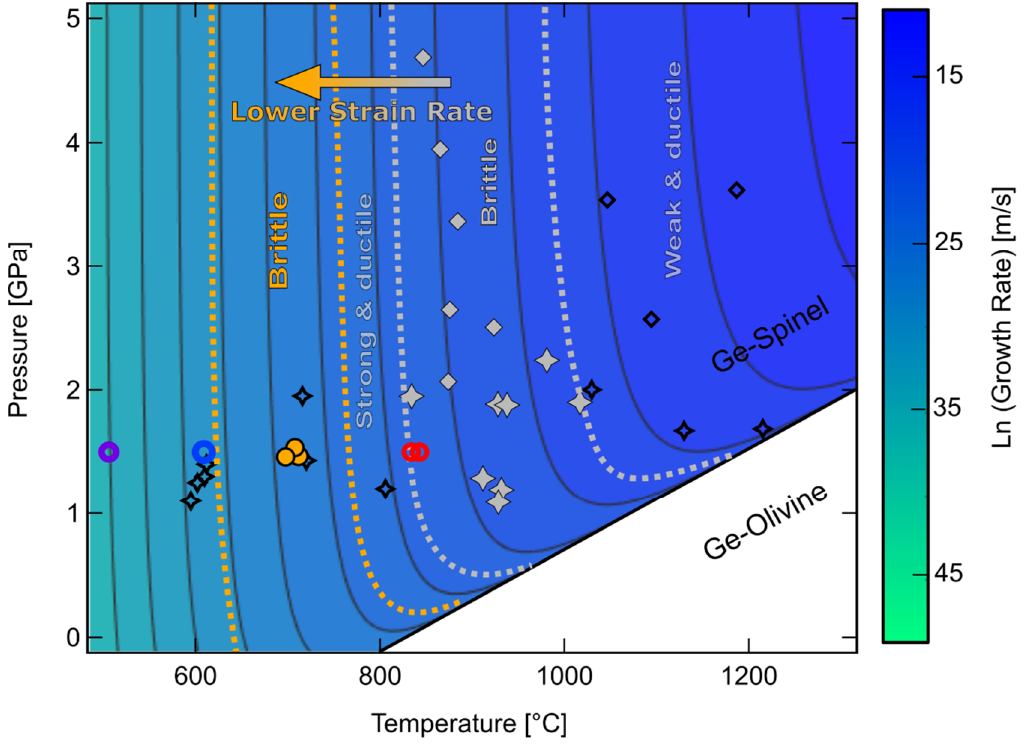
Figure 17. PT conditions of the present study (circles) and those of [15,22] (stars and diamonds, respectively). Open symbols indicate ductile behaviour, even if limited. Full symbols indicate brittle failure. The dashed lines indicate the transformational faulting temperature window identified by previous studies and the present one, at lower temperature and strain rates. The colour-coded grain growth rates are from [36], using thermodynamic data of [25] for free enthalpy of reaction calculation. rates of the newly formed phase. Nucleation rates are difficult to assess experimentally